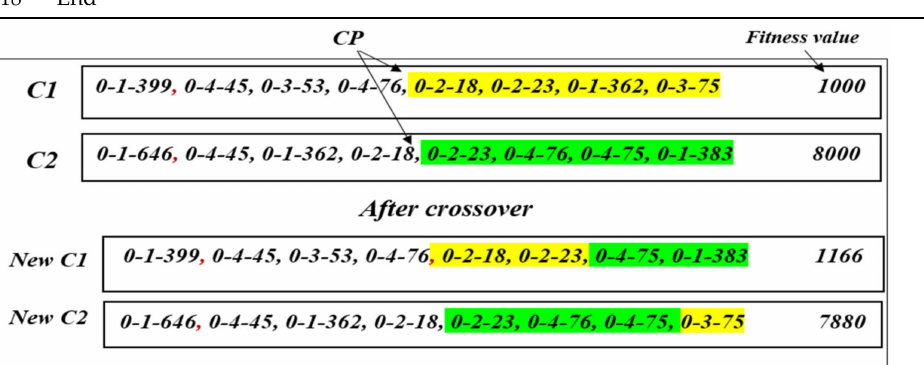
Figure 6. Crossover operator representation.